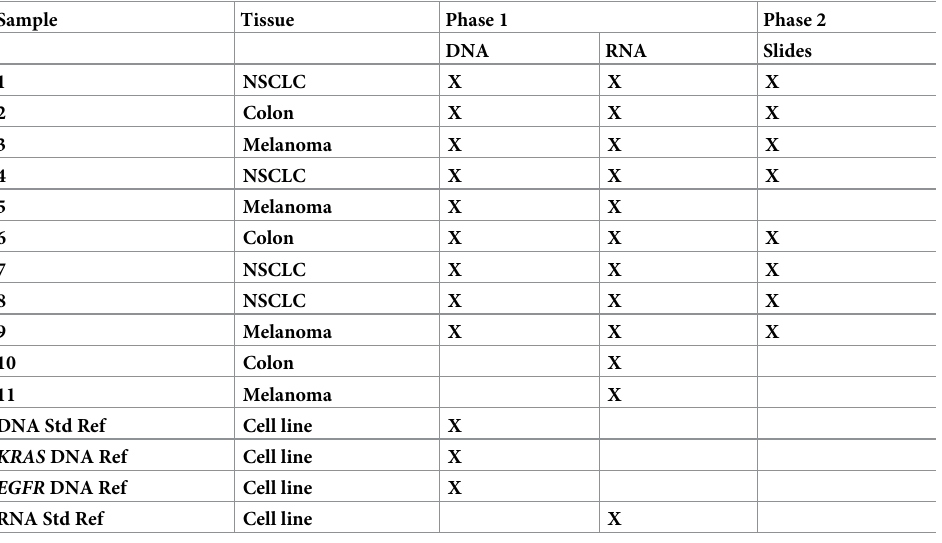
Table 1. List of samples used in the